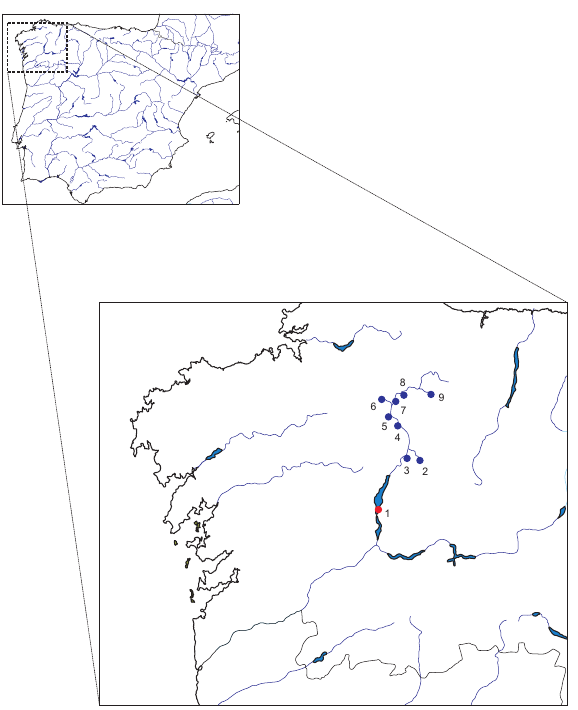
Figure 1. Geographical location of the meteorological stations (blue dots) and the Belesar reservoir (red dot). (1) Belesar reservoir; (2) Sarria river (Pobra de S. Xulian); (3) Neira river (O Paramo); (4) Miño River (Lugo); (5) Narla river (Gondai); (6) Ladra river (Begonte); (7) Miño River (Cela); (8) Miño River (Pontevilar); and (9) Azúmara river (Reguntille).